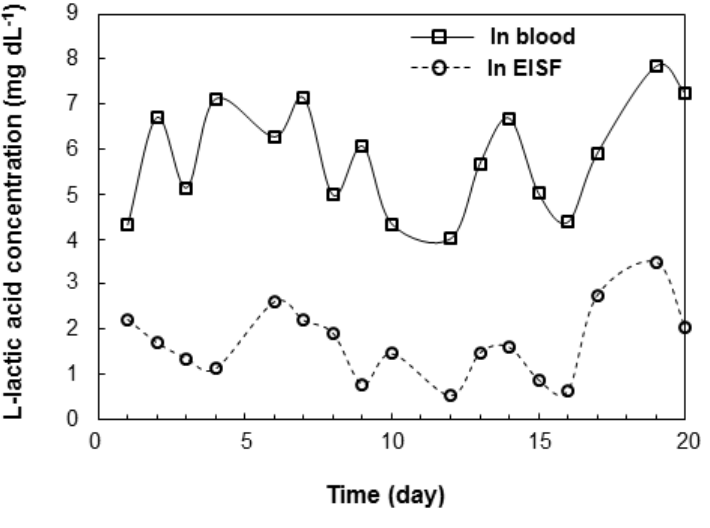
Figure 3. Representative plot of L -lactic acid concentration in the blood and EISF in an individual fish L -Lactic acid concentrations in blood are plotted as white circles and those in EISF are plotted as black